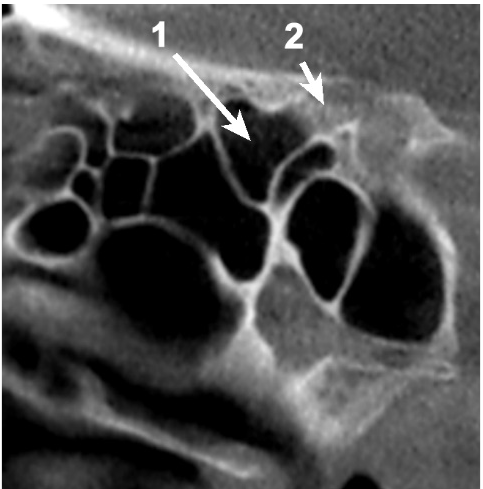
Figure 6. Sagittal CBCT reconstruction, demonstrating the topography of the left optic canal (OC) neighboring the extension of the right sphenoid sinus (false Onodi). 1. Extension of the right sphenoid sinus; 2. Left OC.